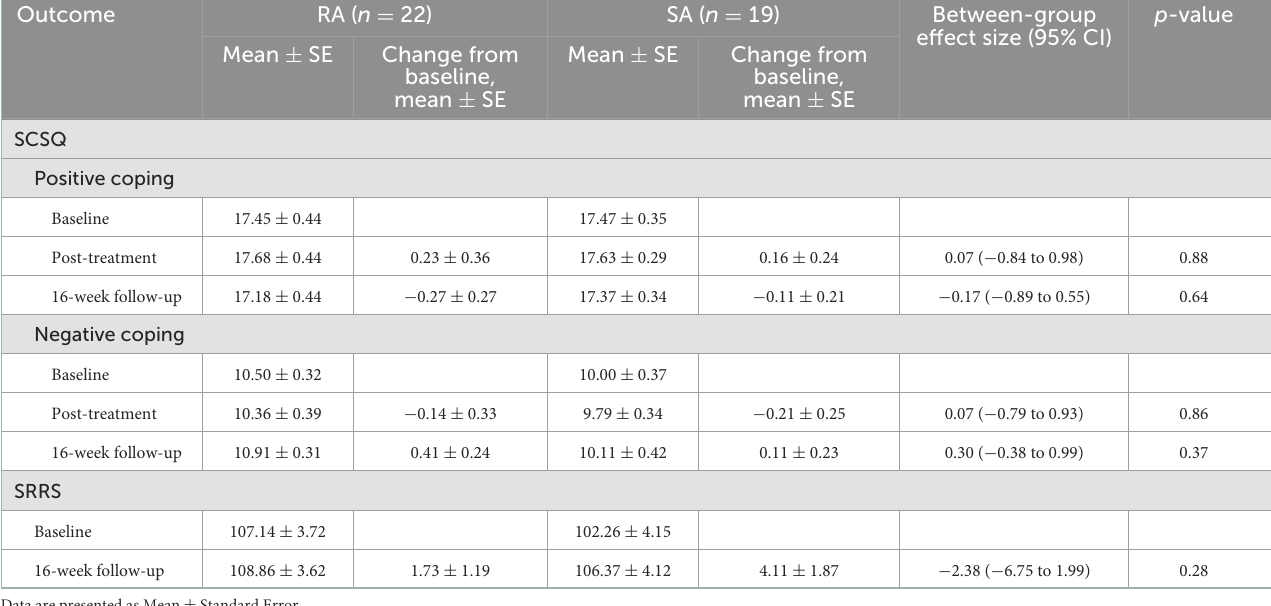
TABLE 6 SCSQ and SRRS outcomes across trial time-points (PP dataset, participants = 41). Outcome RA ( n = 22) SA ( n = 19) Between-group